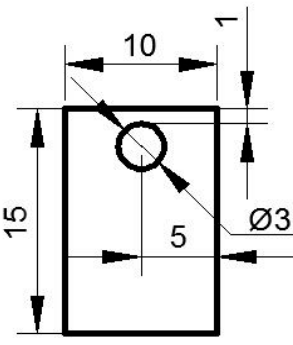
Figure 1. The location of the specimen borehole.